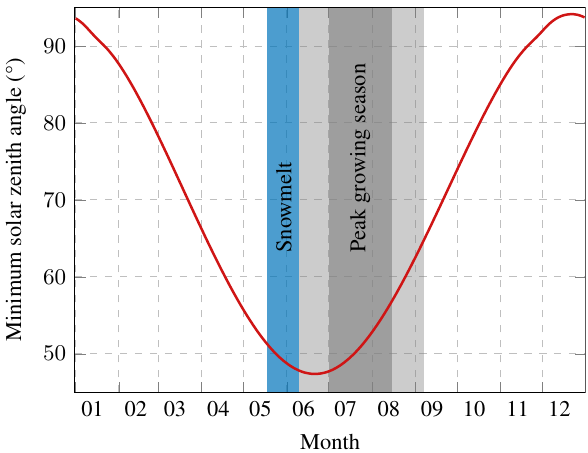
Figure 2. Variation of the solar zenith angle at solar noon (14:10 local time); snowmelt (blue) and growing season (light grey) in dif- ferent years (dates from Parmentier et al., 2011a) and peak growing season (1 July–15